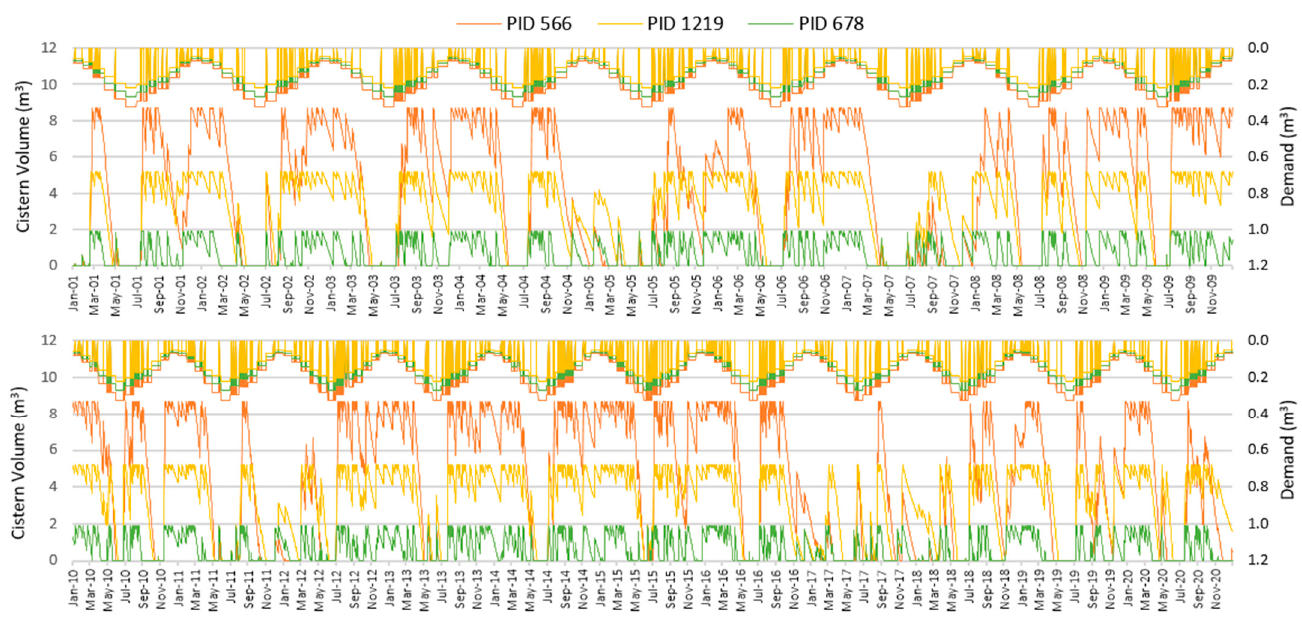
Figure 8. Irrigation demand (secondary axis) and rainwater captured (primary axis) in cisterns for the 20-year time period (years 1–9 on top and years 10–20 on bottom). PID 566 represents the largest cistern capacity (8.91 m 3 ), PID 1219 represents the mean cistern capacity (5.19 m 3 ), and PID 678 represents the smallest cistern capacity (1.91 m 3 ) in the watershed. Water demand for irrigation per square meter of basin area, based on reference evapotranspiration rates in Tucson, was highest from April to August, which is the summer growing period for plants, and lowest during the winter months (Figure 9). However, average infiltrated volumes were highest during the months of July and August, when the precipitation frequency is high. In general, water demand can be met by on-street basin installations for most of the year, except for June, when the demand exceeds infiltration.